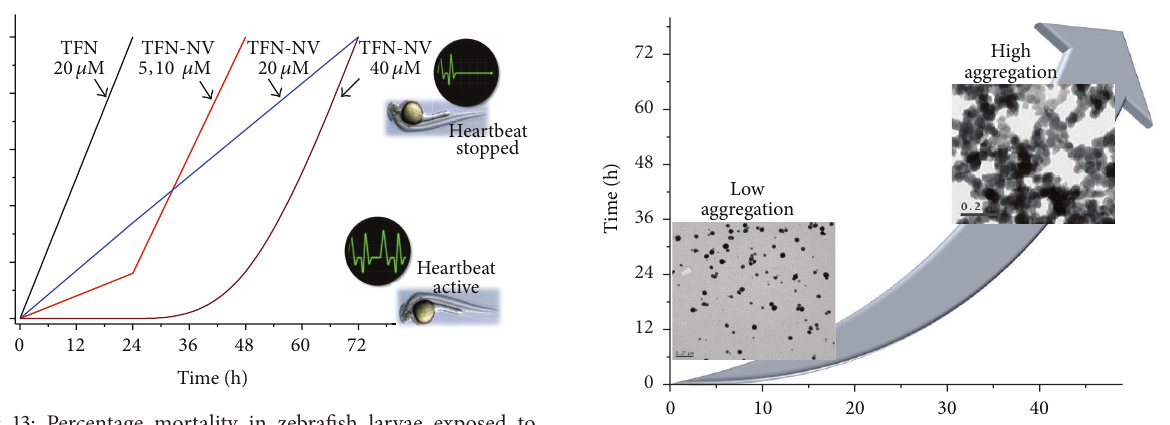
Figure 13: Percentage mortality in zebrafish larvae exposed to various concentrations of TFN-loaded nanovesicles (TFN-NV) at different time points. Figure 14: Graphical representation of increased aggregation and